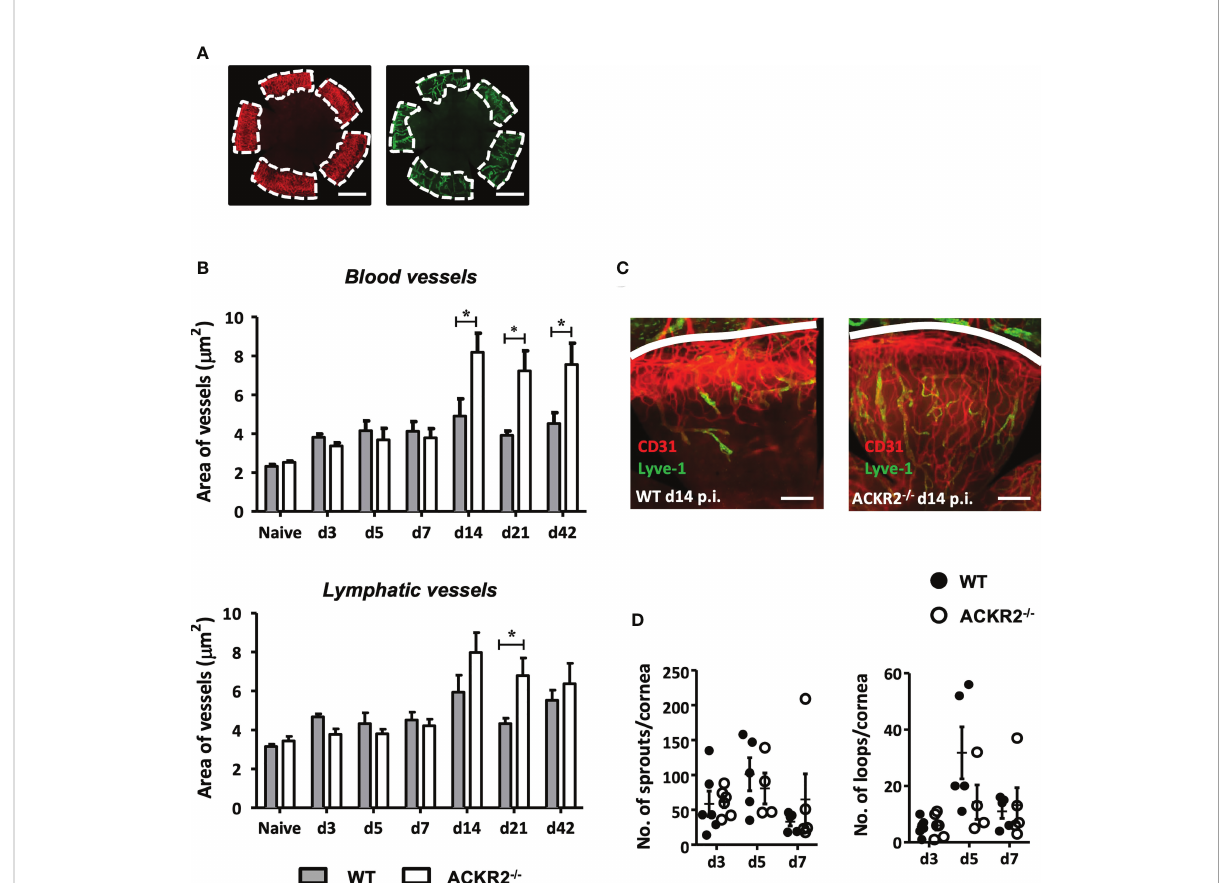
FIGURE 4 Prolonged development of corneal neovascularization but not lymphangiogenesis in ACKR2 -/- mice with HSK. Corneal whole mounts were prepared from ACKR2 -/- and WT mice infected with 5.4 x 10 5 pfu of HSV-1 virus and stained with anti-CD31 (red) and anti-Lyve-1 (green) antibodies for blood and lymphatic vessels respectively. (A) Diagram showing region of vessel quanti fi cation. Area of vessel invasion indicated by the area of cornea inside dotted white line which is determined by the outer limbal vessel arch and the junction of the inner most blood and lymphatic vessels. Scale bar represents 1000 m m. (B) Quanti fi cation of area of blood vessel and lymphatic vessel invasion in infected ACKR2 -/- (clear bar) and WT ( fi lled bar) mice. Corneas from untreated ACKR2 -/- and WT mice were used as naïve controls. N = 4-11. Statistical analysis performed by unpaired student ’ s t test with * p < 0.05. Data are pooled results from independent set of experiments and shown as mean ± SEM. (C) Representative corneal whole mount staining at day 14 p.i. stained for CD31 and Lyve-1. White line indicates limbal vessel arcade. Scale bar represents 200 m m. (D) Quanti fi cation of early lymphangiogenesis in infected corneas of ACKR2-/- (clear circle) and WT ( fi lled circle) mice was performed by numbers of lymphatic sprouts and loops in ImageJ software using the plug-in Lymphatic Vessel Analysis Protocol (LVAP). N =